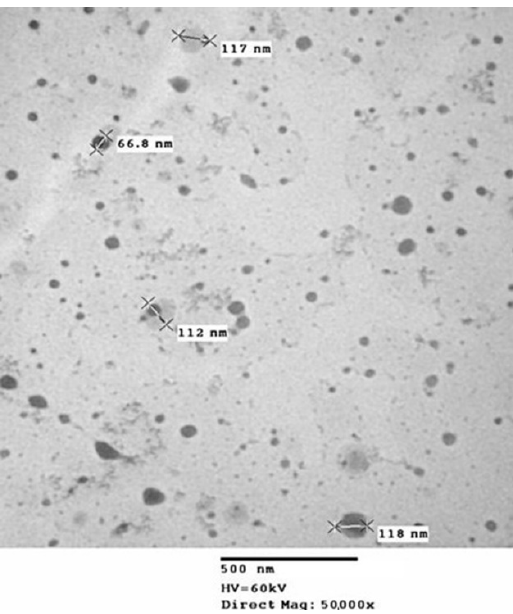
Figure 1. Image of transmission electron microscopy of CH-GSH NPs. 3.2. Chitosan-carrying-glutathione nanoparticles (CH-GSH NPs) are localized into the cells Cells were exposed to two different concentrations of CH-GSH NPs labeled with rho-